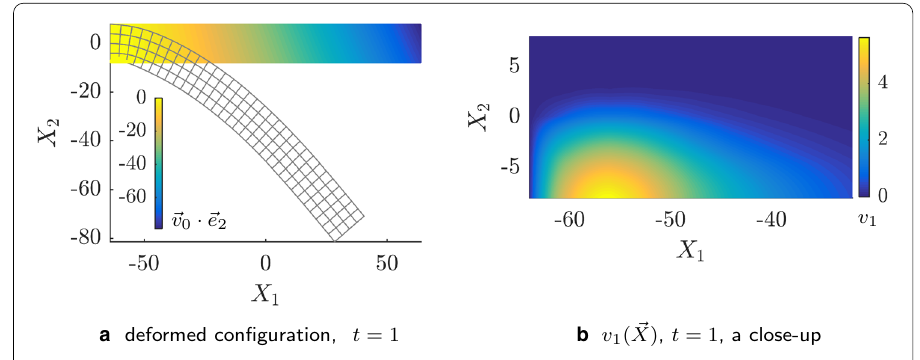
Fig. 6 a Deformed mesh of (cid:2) v 0 ( (cid:2) X ); colour plot shows (cid:2) v 0 · (cid:2) e 2 . b Corresponding field plot of v 1 ( (cid:2) X ), close-up on the left quarter of the specimen. In both cases, t = 1, and the third finest discretization (i.e. h = 4 (cid:20) )